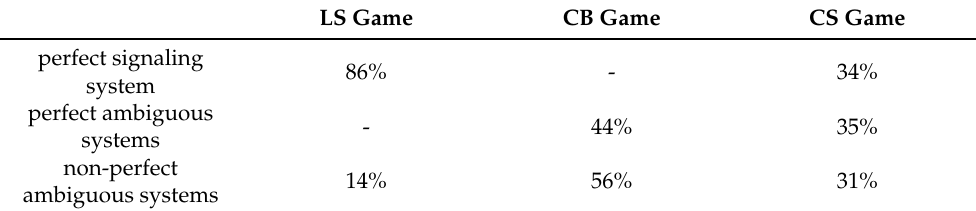
Table 4. Results of the imitation dynamics: 100 agents, no mutation, 100 runs. LS